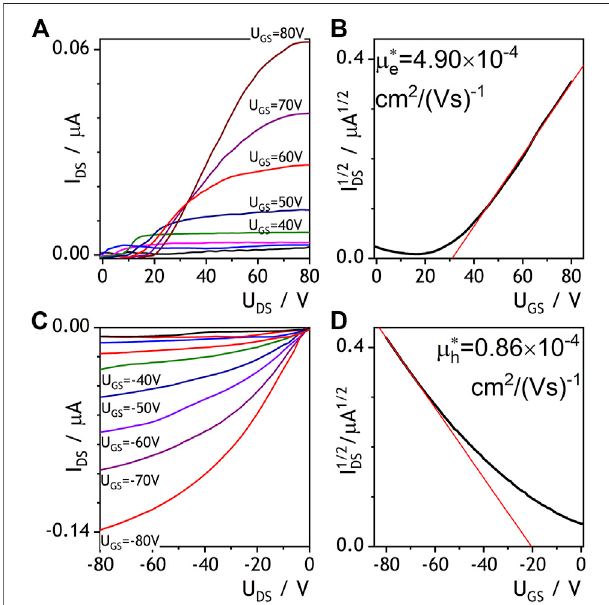
FIGURE 1 | OFET characteristics measured for NDIC8:P3HT blend before (A, B) and after (C, D) solvent vapor annealing. Output curves are shown in panels (A) and (B) , transfer curves are displayed in panels (C) and (D) .